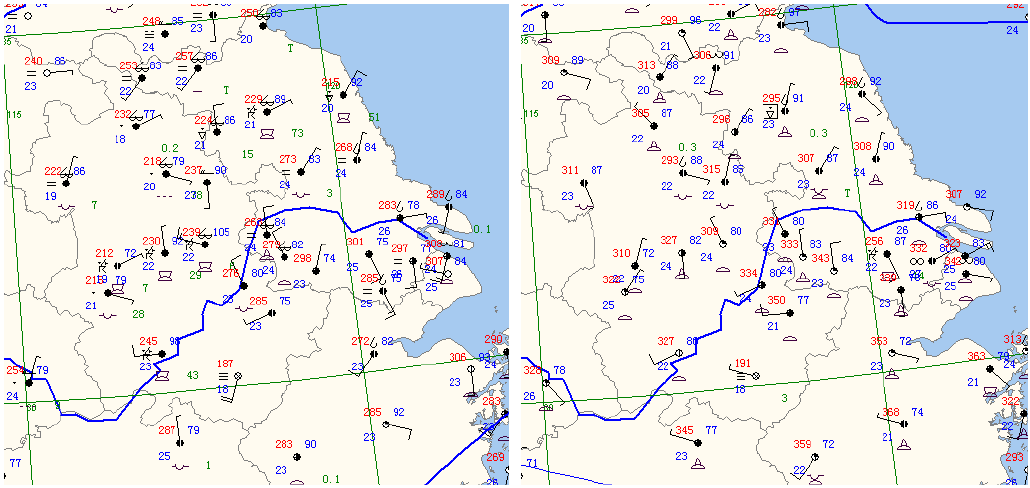
Fig.4. Pressure field at 8:00 LST on August 16 (left) and 14:00 LST on 17 August (right) (from Fig. 4. Pressure field at 08:00LST on 16 August (left) and 14:00 LST on 17 August (right) (from Meteorological Information Comprehensive Meteorological Information Comprehensive Analysis and Process System (MICAPS)) Analysis and Process System (MICAPS)).